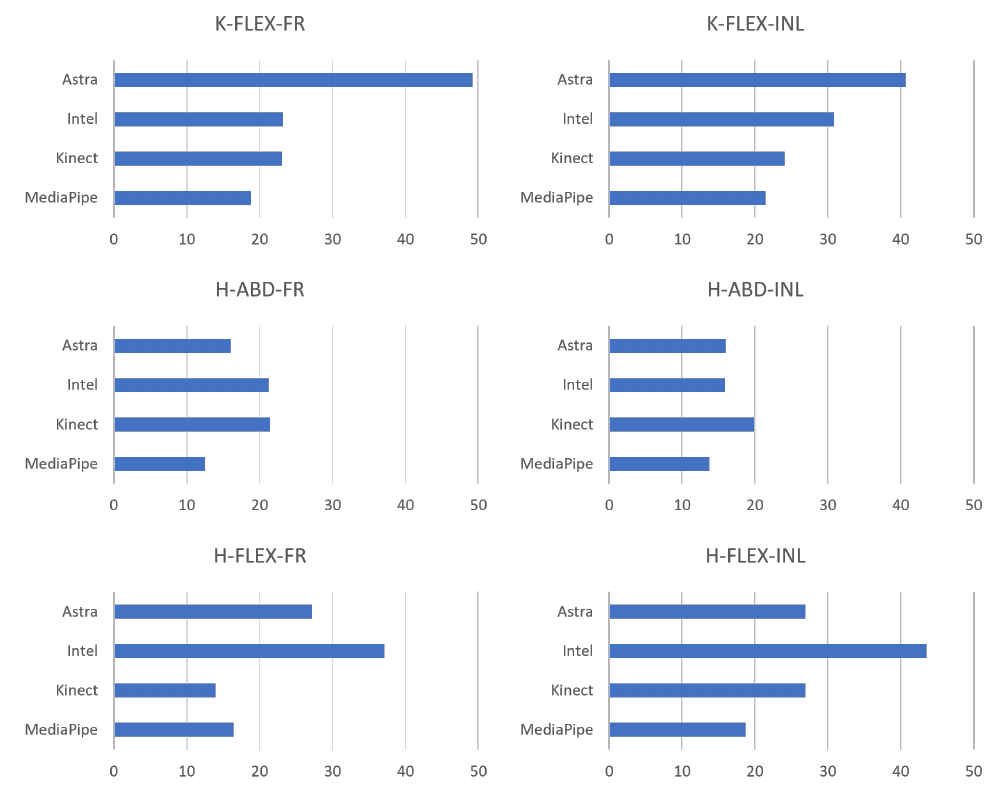
Figure 13. RMS plots of the pooled absolute error (in degrees) for all sensors for LE collection.